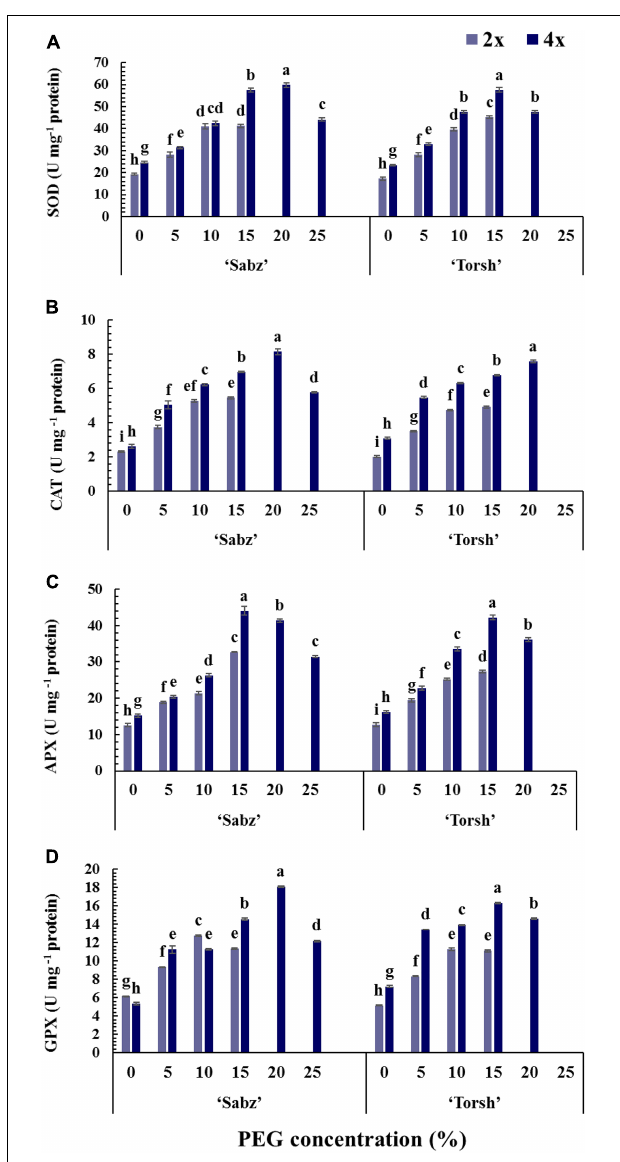
FIGURE 6 | Enzymatic activity responses of diploid and tetraploid explants of ‘Sabz’ and ‘Torsh’ fig cultivars 14 days after subjecting to different water stress treatments. (A) Superoxide dismutase, (B) catalase, (C) ascorbate peroxidase, and (D) glutathione peroxidase. Means represent the ploidy level and PEG treatment effects tested by two-way ANOVA. Each value represents the means ± SE. Different letters indicate significant differences at P < 0.05 using the LSD